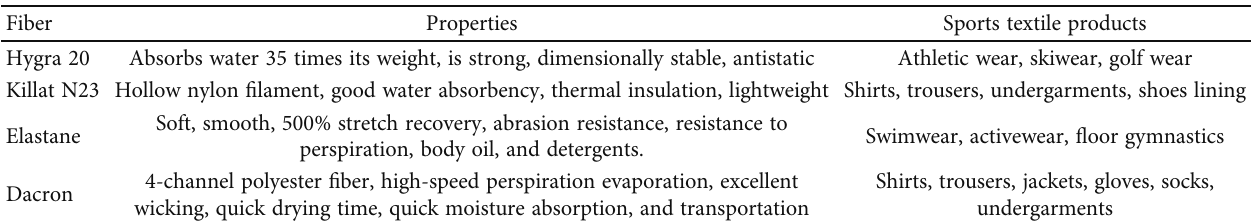
Table 4: Special fi bers properties and their applications in sports textile